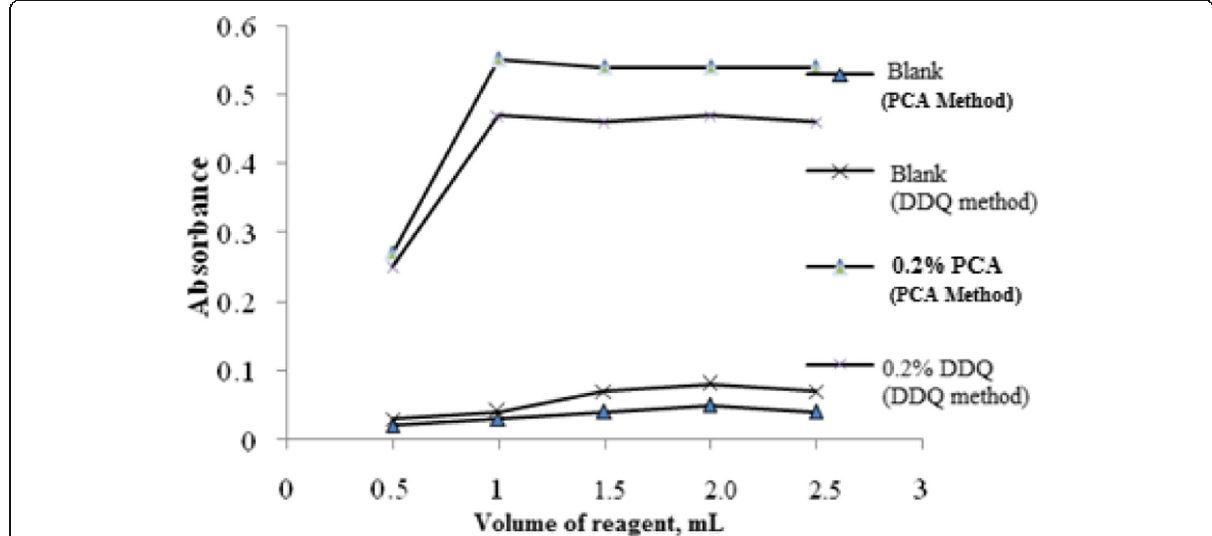
Fig. 3 Effect of PCA and DDQ concentrations on absorbance of respective C-T complexes